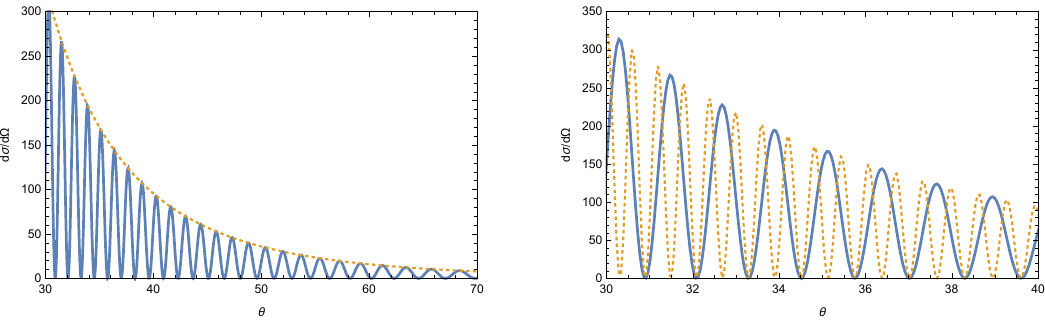
Figure 4. The figure on the left shows the elastic scattering of proton beam of 7 TeV (solid) by a dipole, with a distance between the poles of 0.01 fm. The dotted line represents the envelope of the maxima. The figure on the left shows the effect as we double the pole distance: the shape and position of the oscillations change but the maximum magnitude remains the